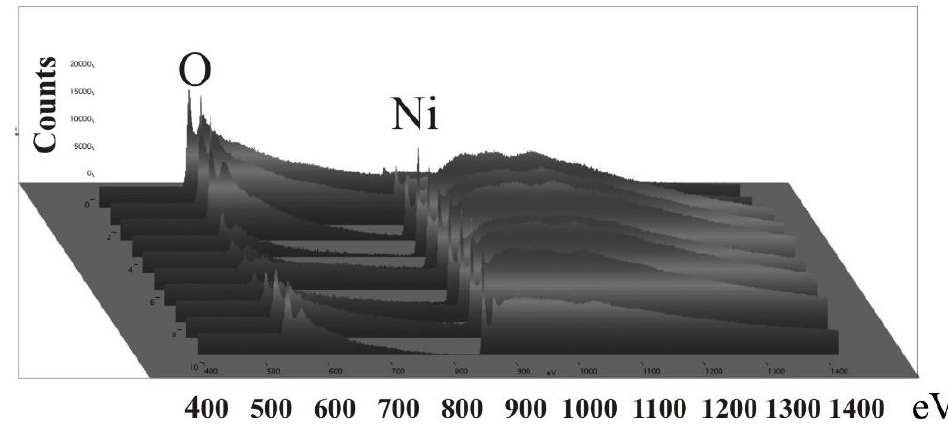
Figure 37. EELS (electron energy loss spectroscopy) spectrum gained from a line scan across an individual Ni-particle (Figure 36, right) within a pore shows the Ni and also oxygen. The high oxygen peak at the edge results from a mixture of SiO wall and NiO [123].